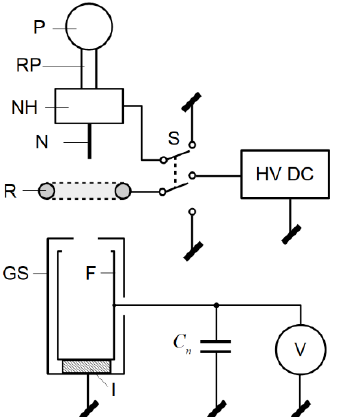
Figure 10. Scheme of the measurement setup. Note: P—pump; RP—rubber pipe; N—nozzle; NH—needle holder; S—switch; R—ring electrode; F—Faraday cup; GS—grounded shield; HV DC—high-voltage DC power supply.